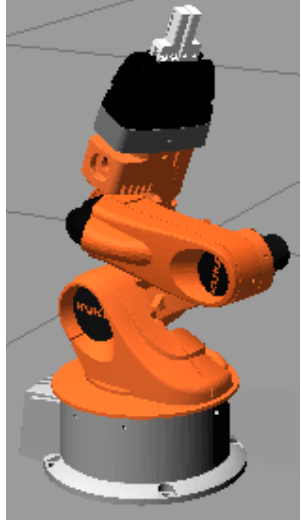
Figure 1. Kuka TM youBot